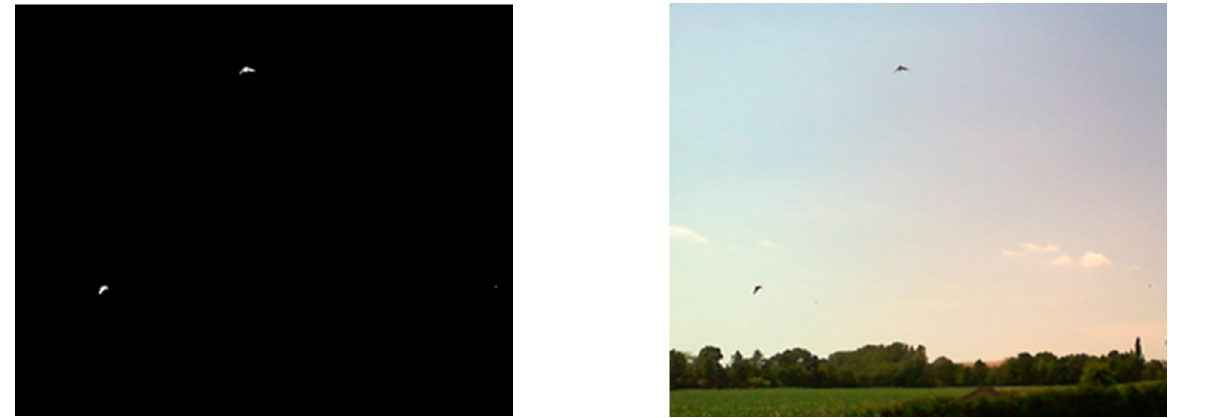
Figure 5. A binary differential image ( left ) and a highlighted region around a detected object ( right ).